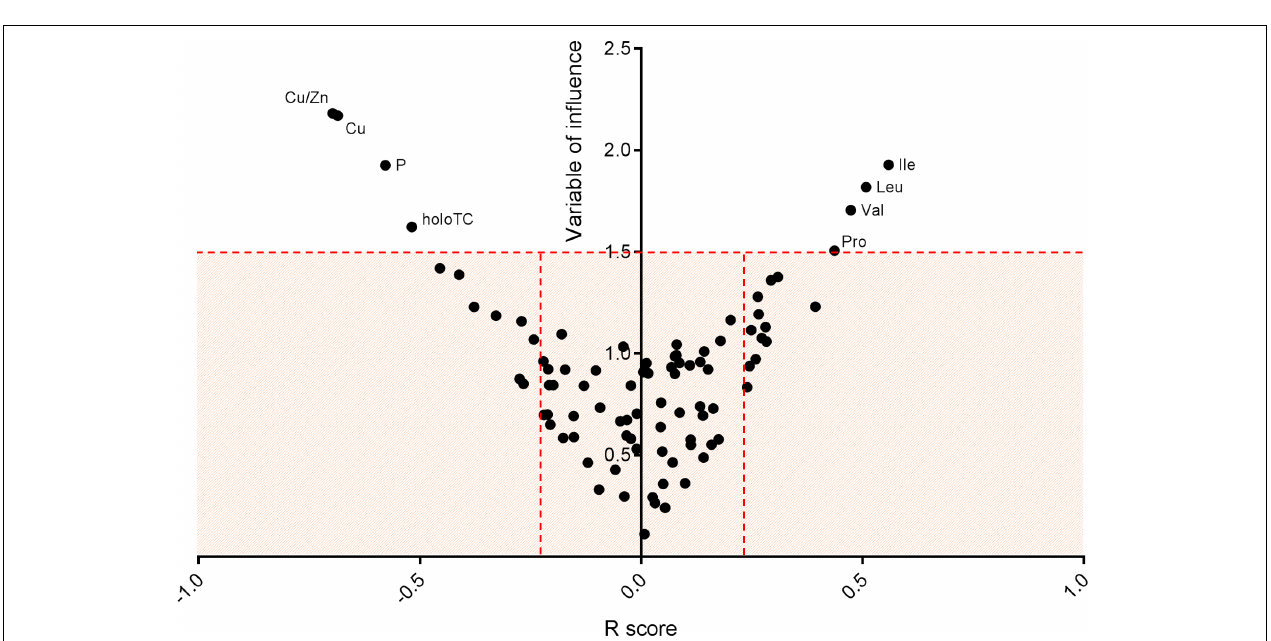
FIGURE 1 | Blood nutrient dataset showed clear separation of sexes. The application of orthogonal corrected partial least squares discriminant analysis (OPLS-DA) to the data set exhibited good predictability of sex from BNP values, as indicated by a cumulative Q 2 Y value of 0.579. Blue triangles correspond to male and red triangles to female individuals.